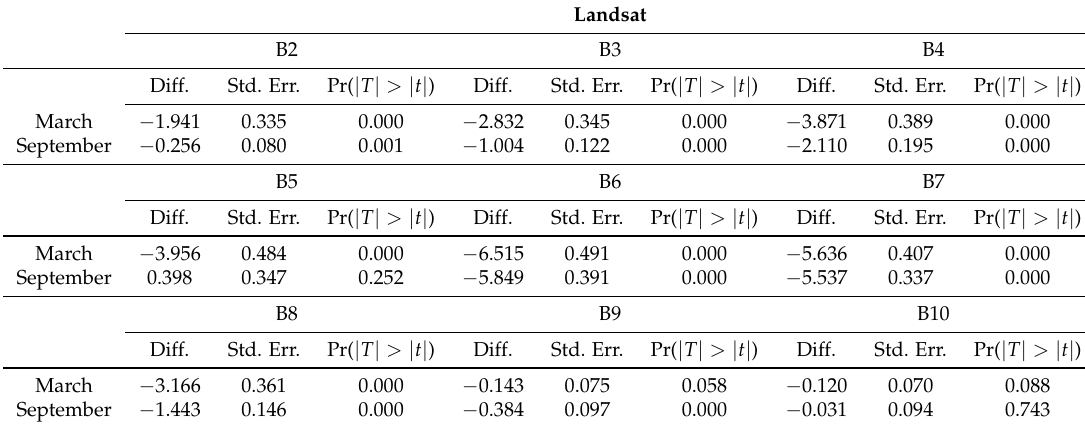
Table A5. Two-sample t -test with unequal variances: comparison of mean reflectance (Landsat 8 and WorldView) of trees and